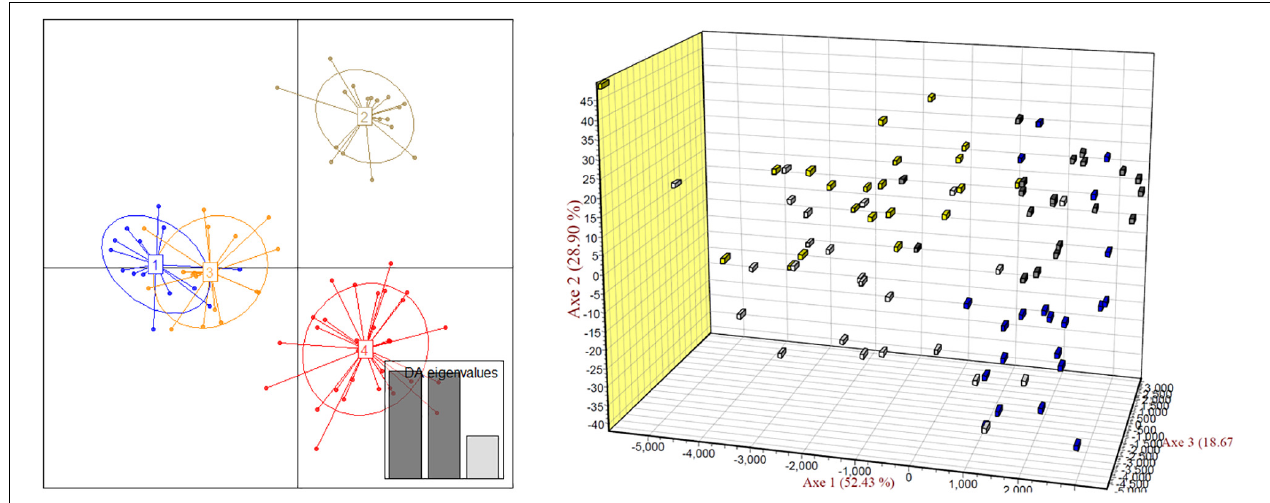
FIGURE 5 | Discriminant analysis of principal components (DAPC, left) and three-dimensional factorial correspondence analysis (3D-FCA, right) showing the relationships among turbot individuals of two 2n and two 4n populations. Yellow block, 2n1; white block, 4n1; blue block, 2n2; gray block,